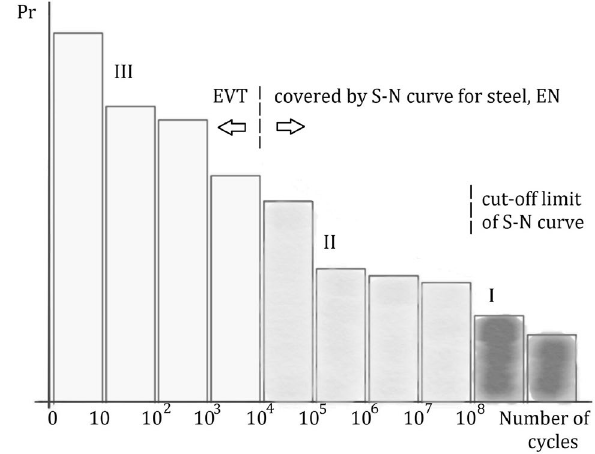
Fig. 2 Relation between stress and number of cycles: (I)-no dam- age, (II)-fatigue damage, (III)-extreme load